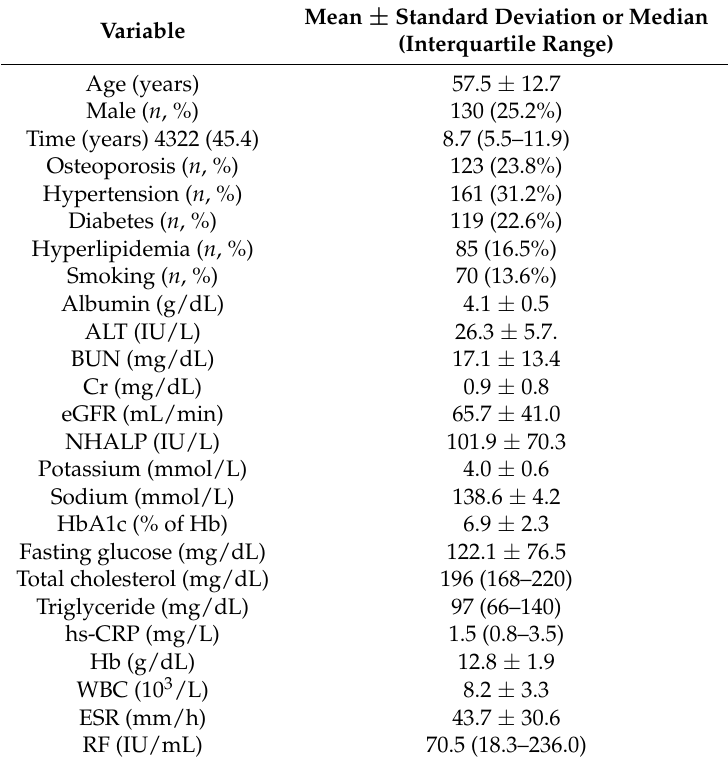
Table 1. Baseline bio-demographic characteristics and relevant laboratory data of the whole study cohort in 516 patients with rheumatoid